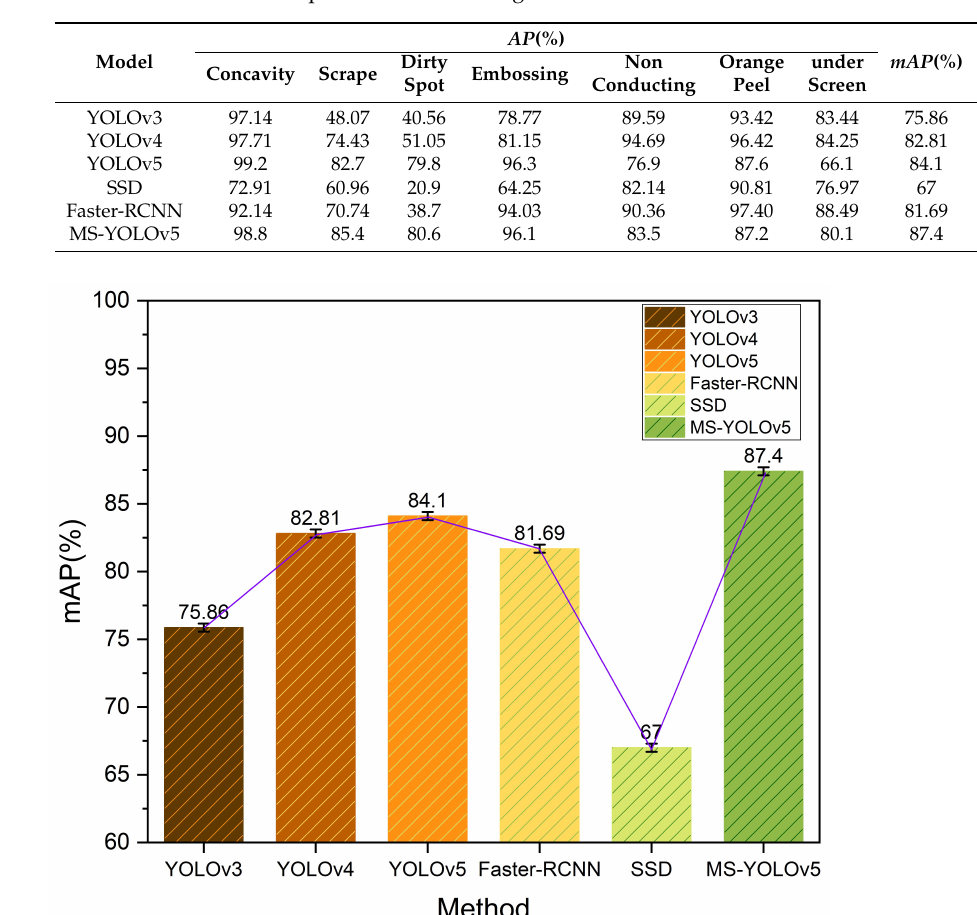
Table 4. Performance comparison of various algorithms.